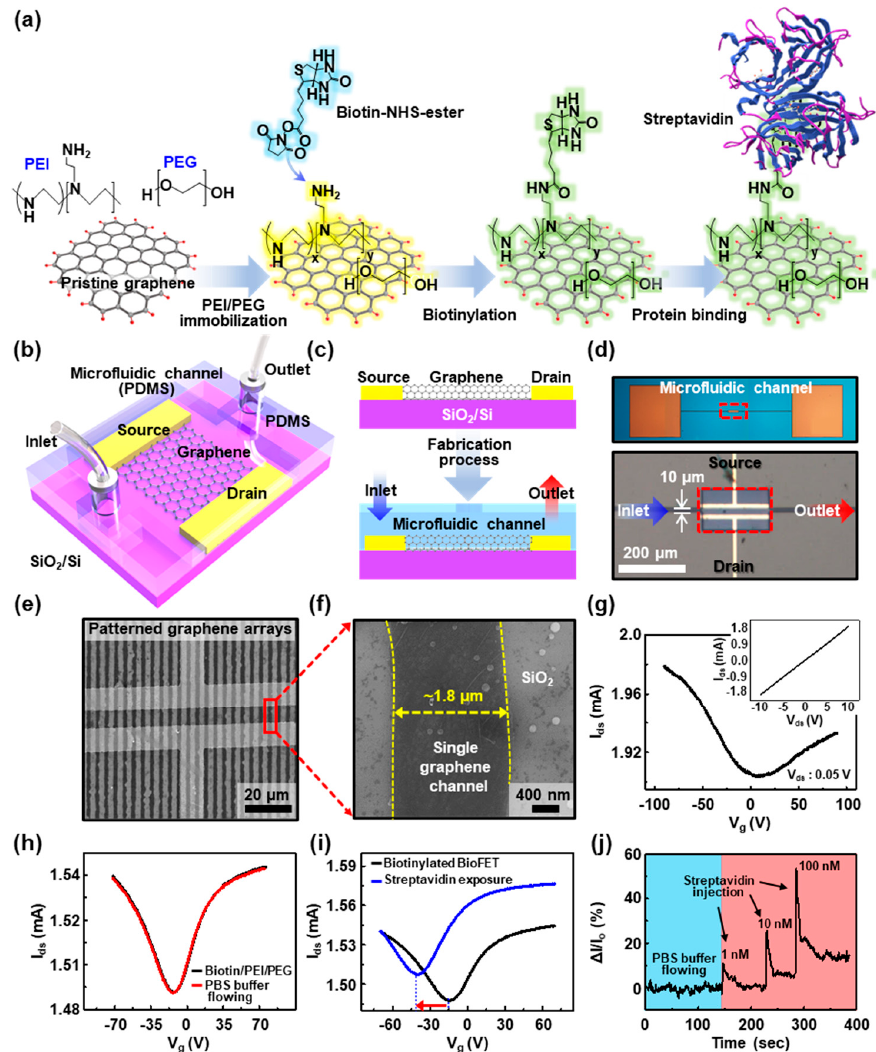
Figure 6. ( a ) Schematic diagram of the chemical modification steps on the graphene active channels to generate the BioGFET. ( b ) Structure of the BioGFET, integrated with a microfluidic channel. ( c ) A cross-sectional view of a microfluidic channel system built with BioGFET. ( d ) Optical micrographs of BioGFETs with a microfluidic channel. ( e ) SEM image of the chemically modified graphene multichannel, built with electric pads. ( f ) Zoom-in image of a single channel of the patterned graphene. ( g ) Gate voltage dependence of source-drain current before the surface modification with biotin/poly(ethylene imine) (PEI)/poly(ethylene glycol) (PEG); inset: current density–voltage ( I – V ) characteristics for a representative device. ( h ) Transfer characteristics according to the flowing of phosphate-buffered saline (PBS) buffer solution after biotin/PEI/PEG polymer coating on the graphene channels. ( i ) Transfer characteristics before and after streptavidin exposure on the active channels in BioGFET. ( j ) The signal was measured by monitoring the current as a function of time for different concentrations of streptavidin.